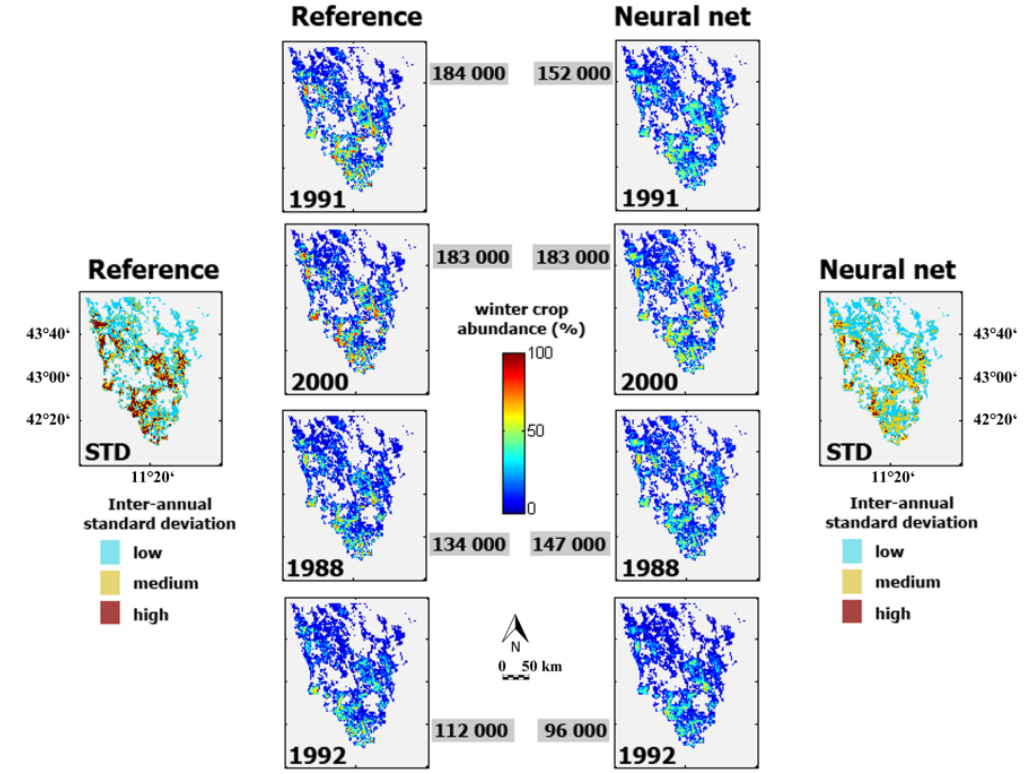
Figure 9. Reference ( left ) and modeled ( right ) winter crop area fractions for the four years for which reference information is available (1988, 1991, 1992 and 2000) and (color-coded) inter-annual standard deviation of the winter crop area. The total surfaces (ha) for the entire region are indicated next to the maps. All estimates were obtained in leave-one-out mode.